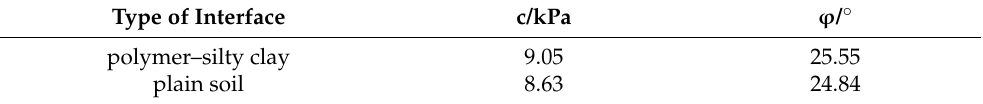
Table 10. The shear strength indexes of polymer – silty clay interface and plain soil.